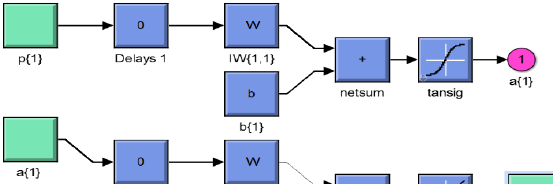
Figure 2. Layers of PFFNN. Figure 3. Weights and biases of PFFNN.